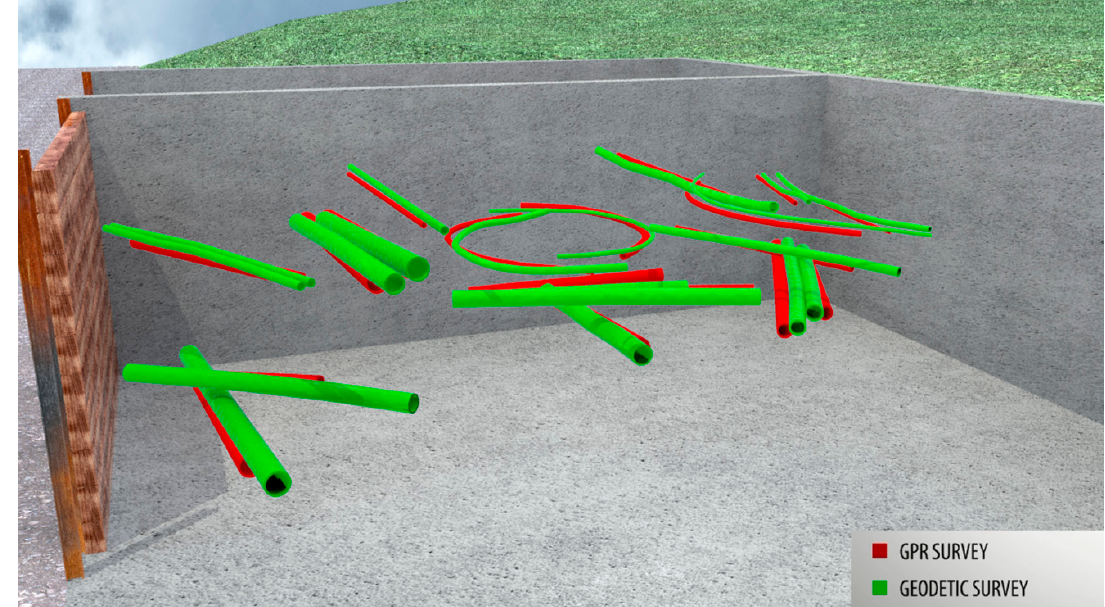
Figure 21. Installed cables, cable ducts and pipes positions comparison and deviations (GPR-TPS model, red colour) from the reference (polar measurement method, green colour).